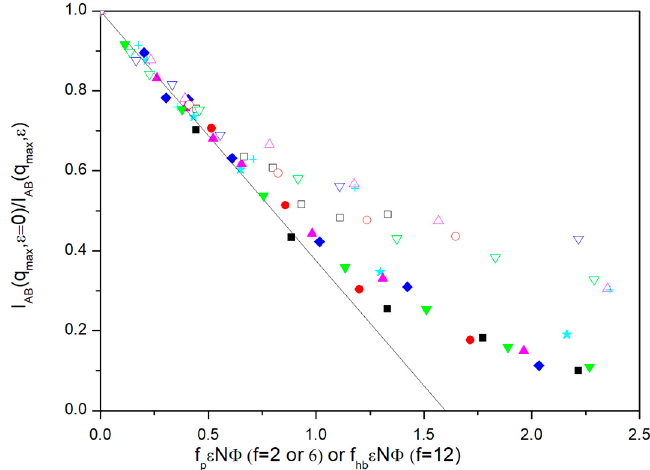
Figure 2. Ratio between scattering functions obtained with opposite optical contrast factors for A and B units without segregation and with different values of ε vs. f P ε N Φ for f = 2 and f = 6, or f hb ε N Φ for f = 12, see text. Blue rhombuses, N = 144, f = 2; red circles: N = 145, f = 6; magenta triangles up: N = 145, f = 12; cyan stars: N = 72, f = 2; black squares, N = 73, f = 6 , green triangles down: N = 73, f = 12 . Filled symbols correspond to Φ ≅ 0.275 and open symbols correspond to Φ ≅ 0.135. Solid black line: best fit of the points in the linear region of low ε values.